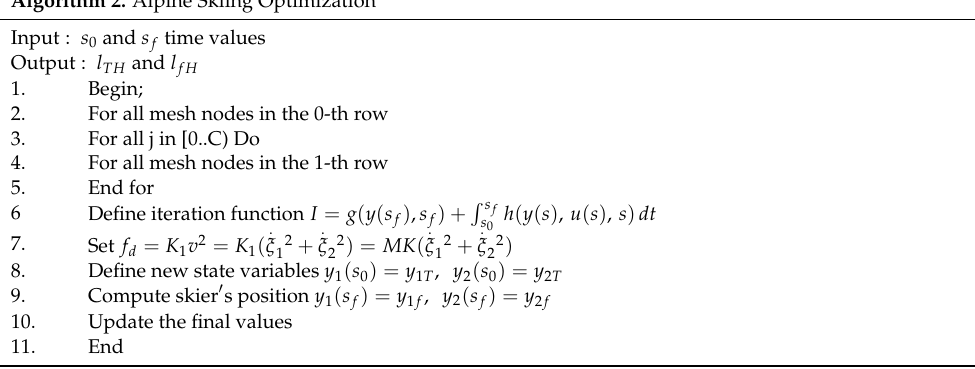
Algorithm 2. Alpine Skiing